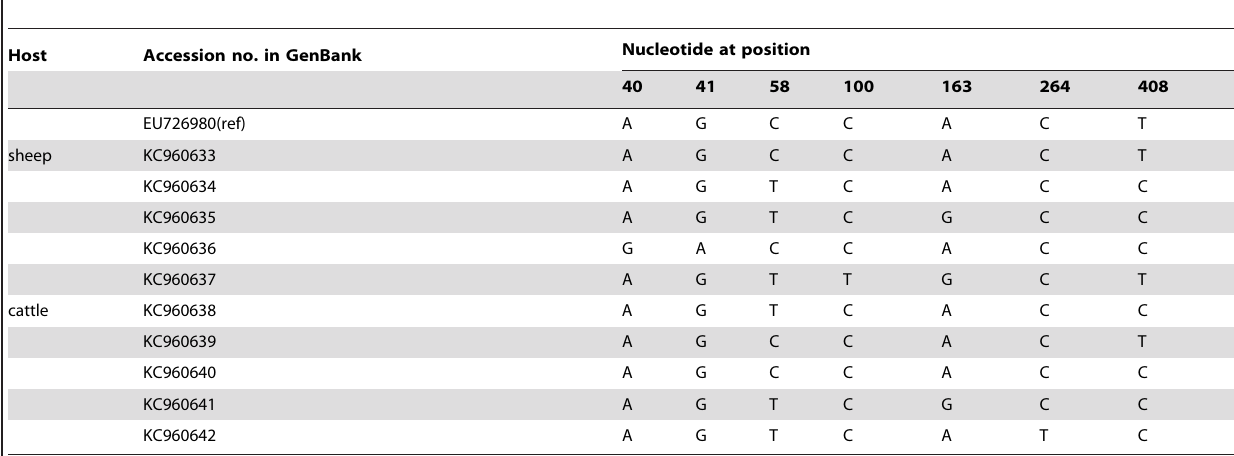
Table 3. Variations at the bg locus among intra-assemblage E of G. duodenalis isolates from sheep and cattle in Heilongjiang Province,